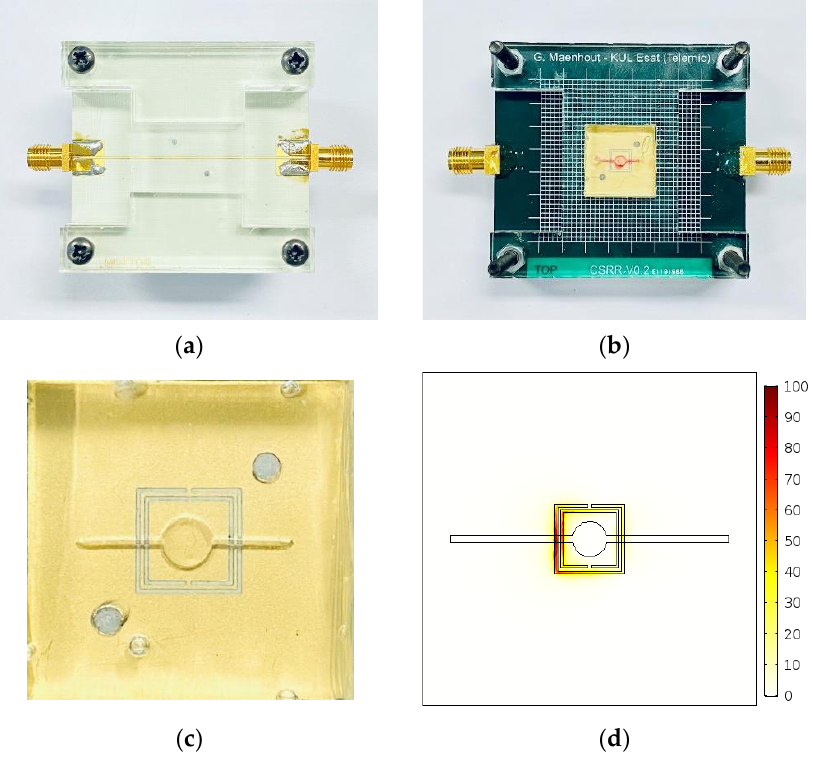
Figure 3. ( a ) A bottom view of the CSRR together with coaxial connectors and PMMA mechanical holder. ( b ) A top view of the CSRR together with the PDMS slab with the microwell and microfluidic channel. ( c ) A close-up view of the CSRR, microwell and microchannel. ( d ) The electric field strength in kV/m in the microwell with water 1 µm above the patch.